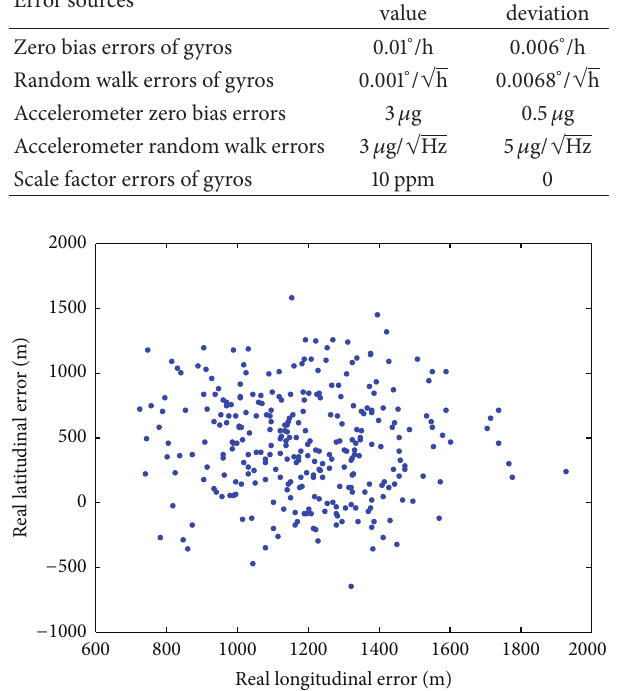
Figure 2: Real distributing points of positioning